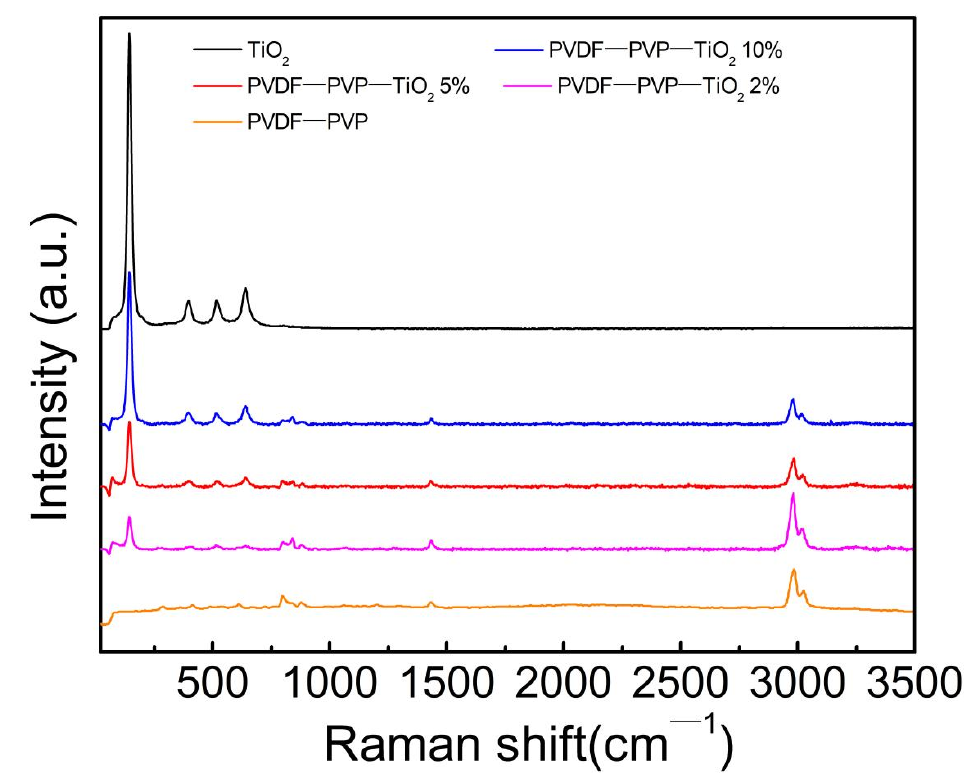
Figure 3. Raman spectroscopy of TiO 2 nanoparticles, PVDF–PVP–TiO 2 fiber mats, and PVDF–PVP.